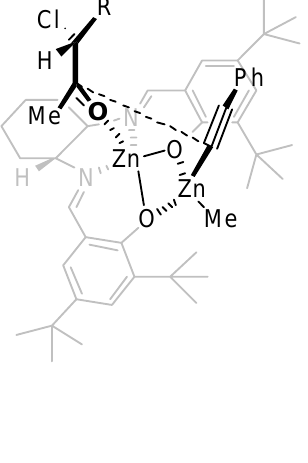
Figure 1. Stereoselective addition of phenylacetylene on the